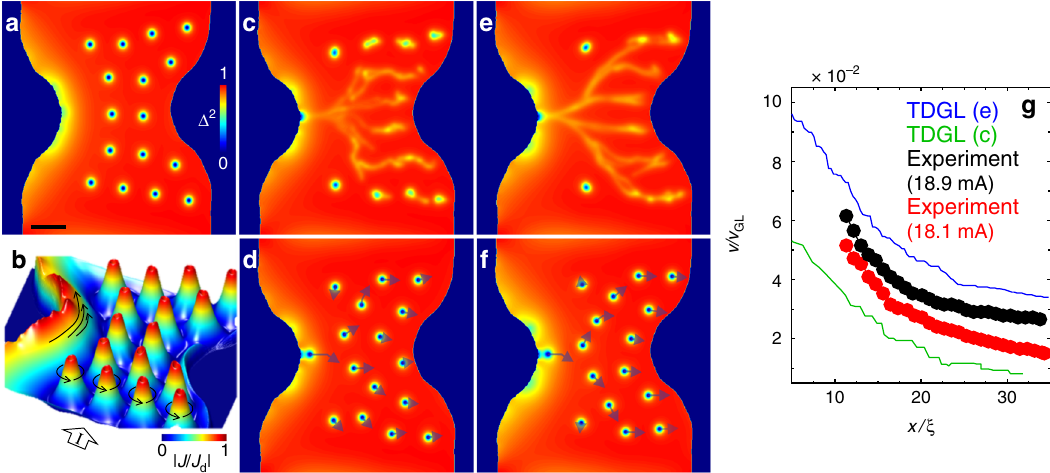
Fig. 5 TDGL simulations of stationary and fast moving vortices at the experimentally accessible velocities. a Calculated Cooper-pair density Δ 2 ( x , y ) of a stationary vortex con fi guration at applied current density and magnetic fi eld corresponding to the experimental conditions in Fig. 2f. b Corresponding distribution of the supercurrent density | J ( x , y )/ J d | in the sample showing edge currents in the constriction reaching J d at the verge of vortex penetration. The black arrows point to the local direction of the current. c Time-average of the Cooper-pair density over 5 × 10 4 τ GL at I = 1.05 I c , revealing branching vortex trajectories coexisting with adjacent stationary vortices. d Snapshot of moving vortices in c with arrows denoting the relative displacement of each vortex following an entry of a new vortex into the sample. e , f Same as c , d but at highest applied current before an additional stem is formed. g Experimental vortex velocity along the stem for B a = 2.7 mT and indicated applied currents with the TDGL data from d and f in normalized units (scaled to v GL = ξ / τ GL ). The animation of the vortex fl ow dynamics corresponding to e , f is presented in Supplementary Videos 5 and 6. The scale bar in a is 20 neglected. The simulated Cooper pair density Δ 2 ( x , y ) shown in Fig. 5a reproduces the main features of the SOT images at I ≲ I c , namely vortices displaced to the right edge and a pronounced vortex-free region along the left edge. Notice that in the absence of disorder, the stationary vortices in Fig. 5a form an ordered structure within a smooth con fi ning potential of the geometrical barrier, in contrast to Fig. 2f which shows a disordered vortex con fi guration determined by pinning in the right-hand side of the sample where J < J c . At I = I c the calculated current density J ( x ) shown in Fig. 5b reaches the depairing limit J d at the left edge of the constriction and vanishes at the opposite edge. At I > I c vortices start penetrating through the left edge and move along a network of preferable paths forming a branching tree with an overall shape determined by the bridge geometry.